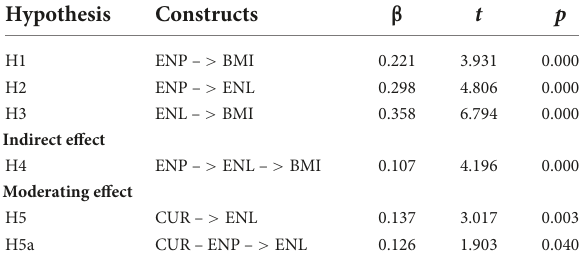
TABLE 7 Hypotheses